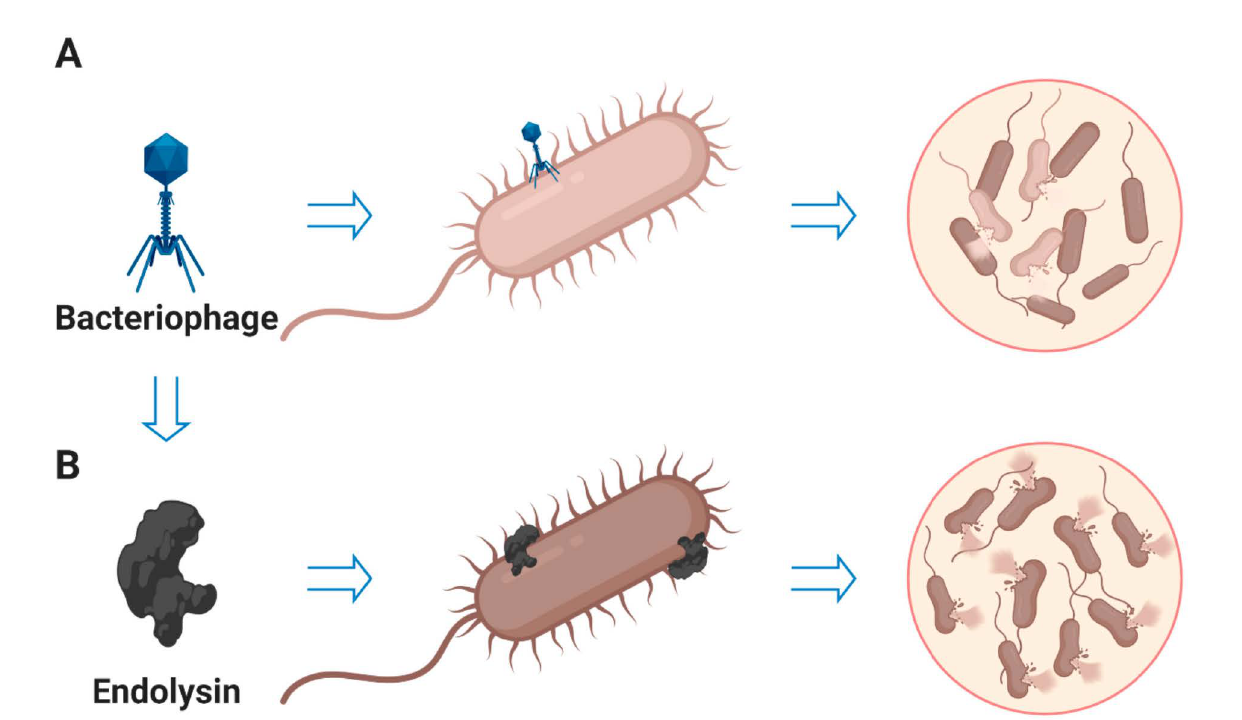
Figure 5. The schematic diagram shows the lytic efficacy of bacteriophages and endolysins. ( A ) Bacterial strains getting resistance against specific phage after phage therapy. ( B ) Phage endolysin therapy shows better killing efficiency than phage cocktail